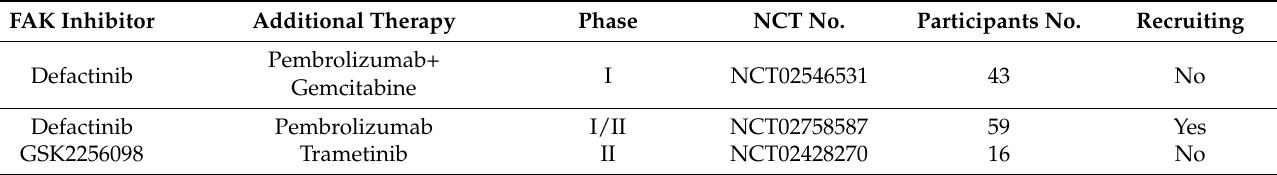
FAK: focal adhesion